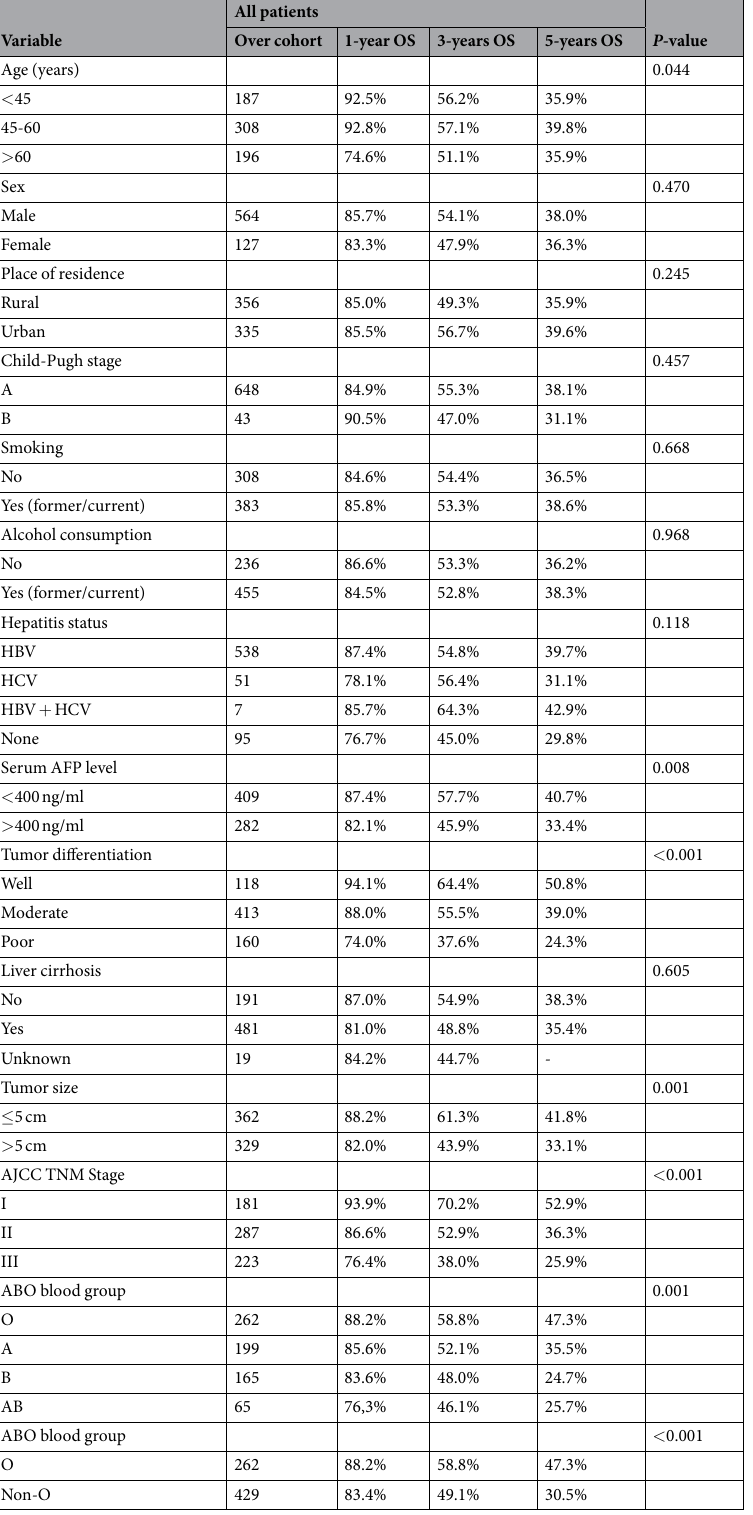
Table 2. Prognostic factors for overall survival by univariate